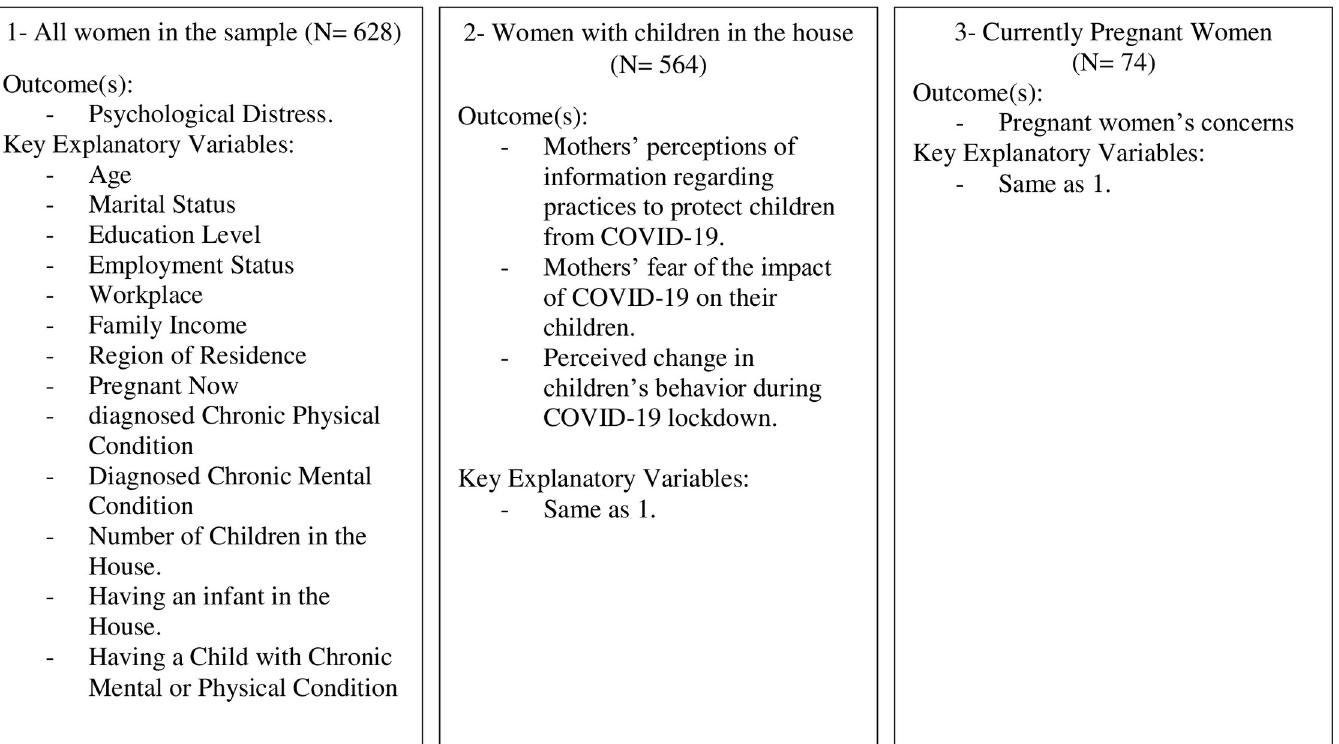
Fig 1. Study’s sample, subsamples, and measured